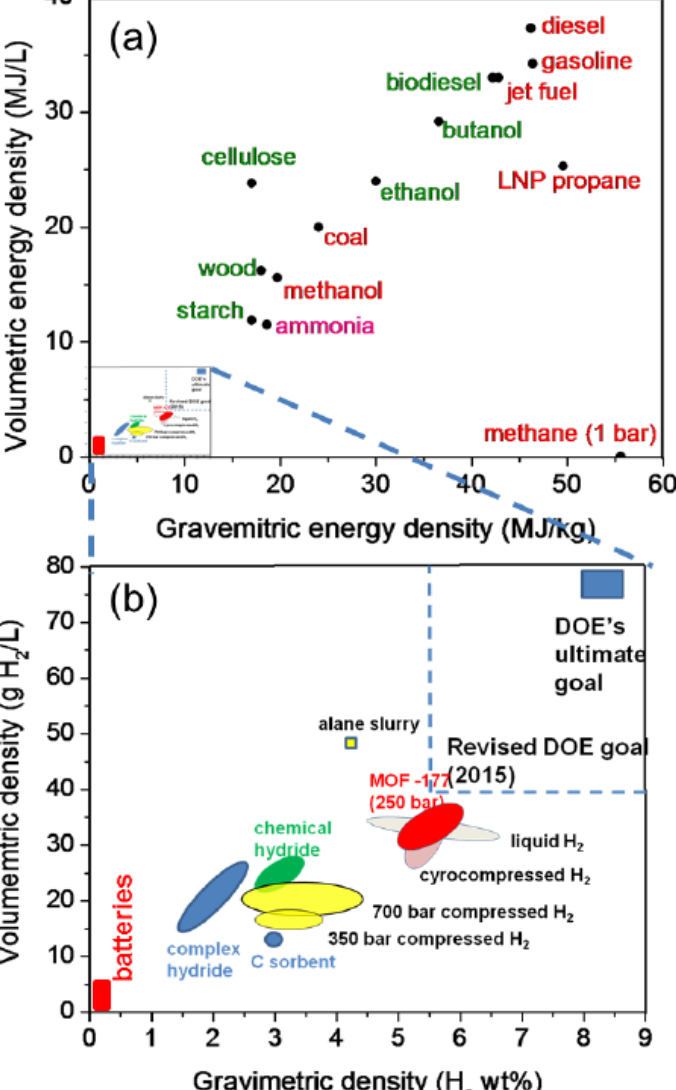
Figure 1. Comparison of gravimetric densities and volumetric densities for liquid fuels, solid fuels, hydrogen storage means, and